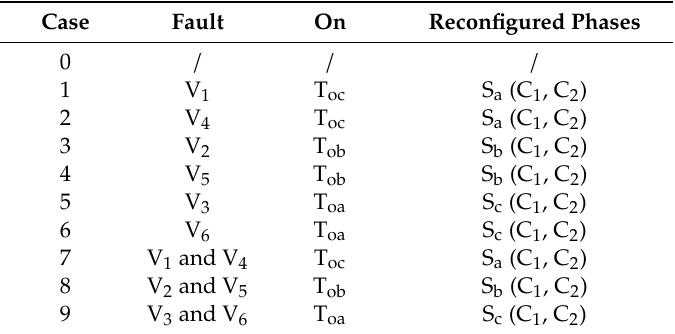
Table 2. The traditional inverter switching status.